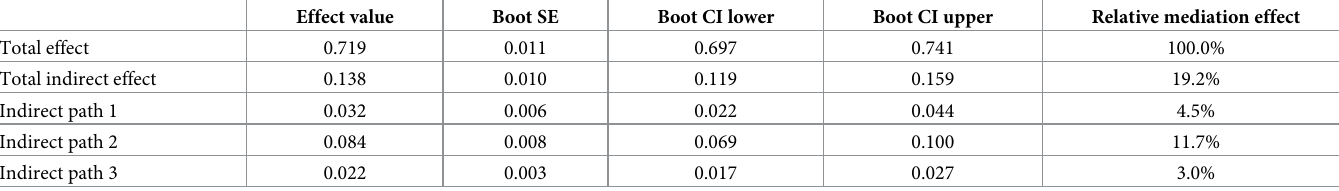
Table 4. The mediating effect of sleep quality and QoL between anxiety and